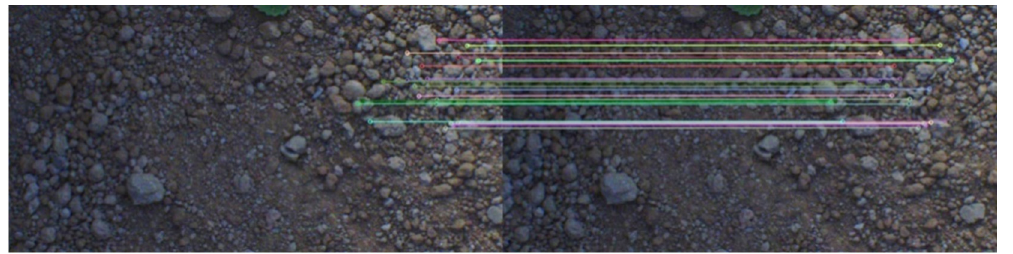
Figure 4. Matching results of the inter-frame ground images.